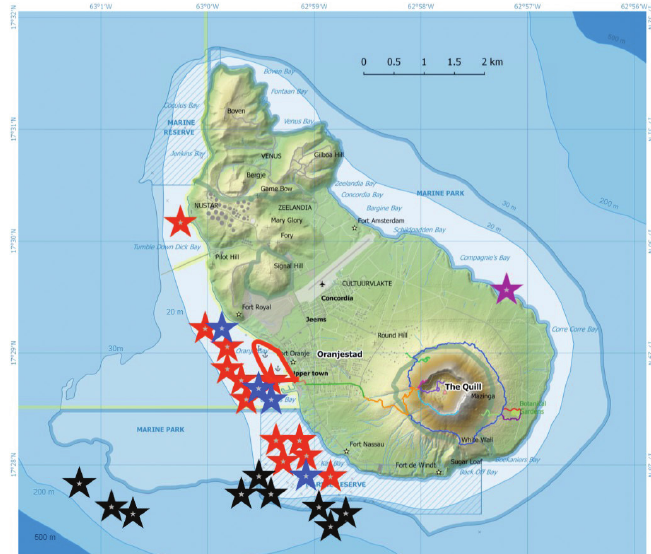
Figure 2. Study sites at Sint Eustatius Island. Location of dive sites during 2017 and 2020: Black stars indicate submersible dives, blue stars 2017 SCUBA dives, red stars 2020 SCUBA dives (some individual stars indicate multiple dives in very close proximity), purple star an intertidal snorkeling site, and the red outline shows limits of the shore-diving area in 2020. See Suppl. material 2: Table S1 for georeferenced date on dive sites. Generalized 20 m, 30 m, 200 m and 500 m isobaths in blue; other lines indicate marine and terrestrial reserve areas. (Base map from Statiaparks, openstreemap.org, CC-BY-SA 2.0 with bathym- etry data corrected from CARMABI/WWF/E.Imms (https://www.dcbd.nl/document/bathymetry-map- seas-surrounding-st-eustatius-saba-and-st-maarten, accessed 10 July